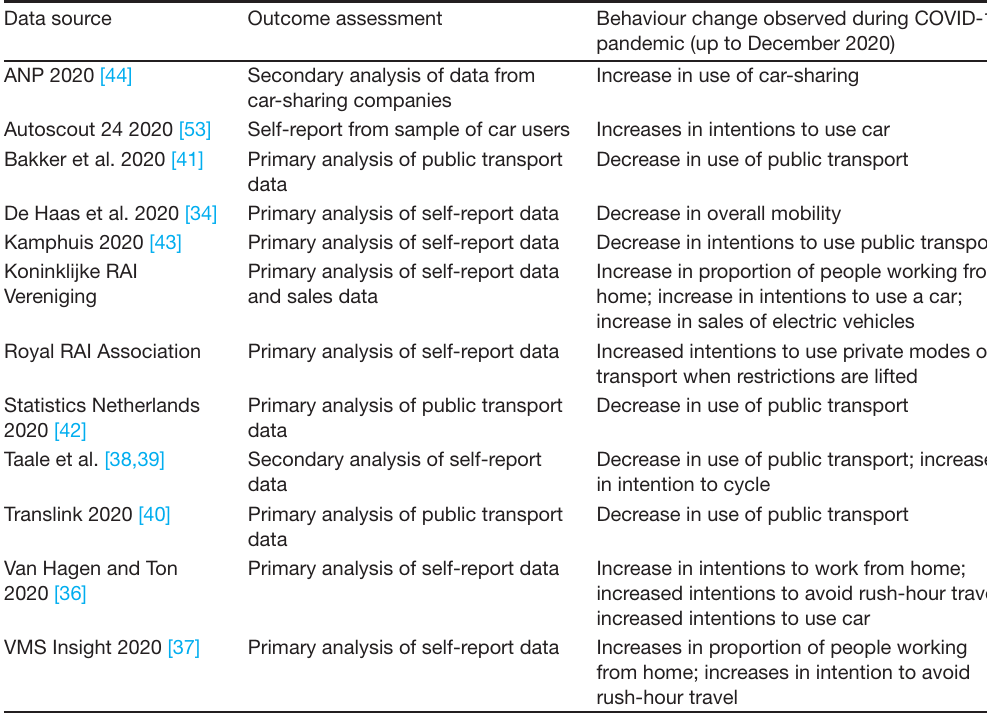
Table A1. Data sources for the Netherlands case Data